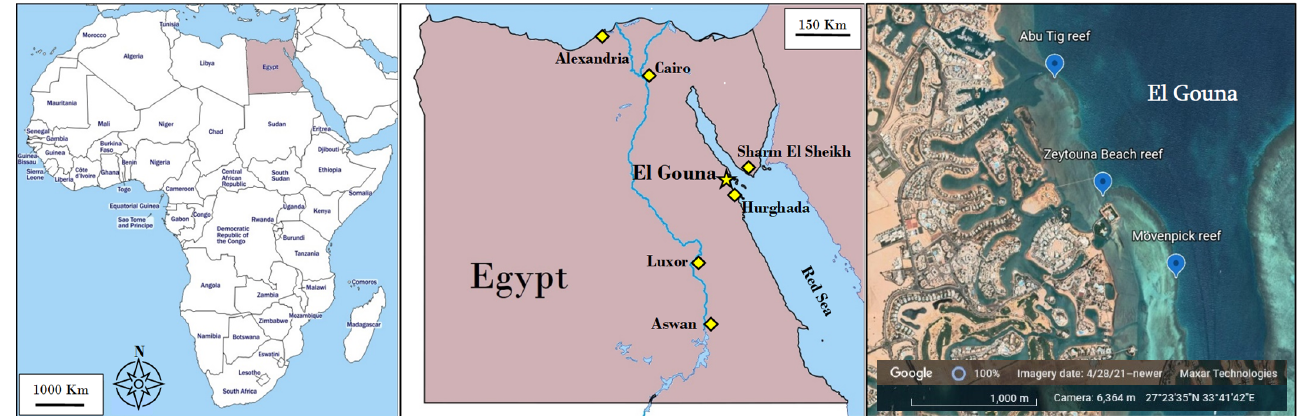
Figure 1. Location of the three reefs in El Gouna, on the Egyptian Red Sea coast, where collections took place. Maps adapted from d-maps.com (https://d-maps.com/carte.php?num_car=4338&lang=en and https://d-maps.com/carte.php?num_car=916&lang=en) and Google Earth (https://earth.google.com/web/).